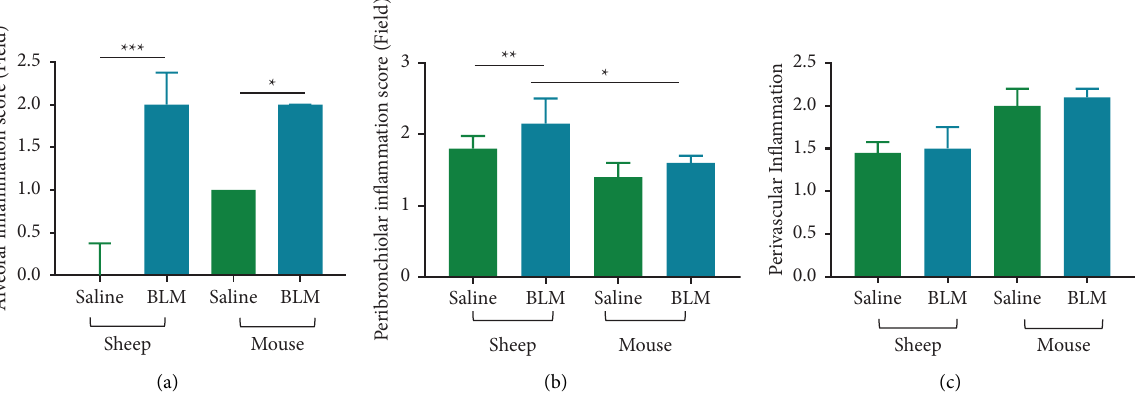
Figure 3: Alveolar infammation (a), peribronchiolar (b), and perivascular (c) infammation of sheep ( n � 8) and mouse ( n � 14) lung tissues infused with either saline (control) or bleomycin (treatment). Te data were evaluated for tissue sections stained with H&E. Ten rep- resentative randomly selected areas from each lung tissue section were captured under × 20 magnifcation for the analysis. All the data were expressed as the median and interquartile range. Signifcance was determined using the Mann–Whitney test and denoted as follows: ∗ p < 0 . 05, ∗∗ p < 0 . 005, and ∗∗∗ p < 0 .